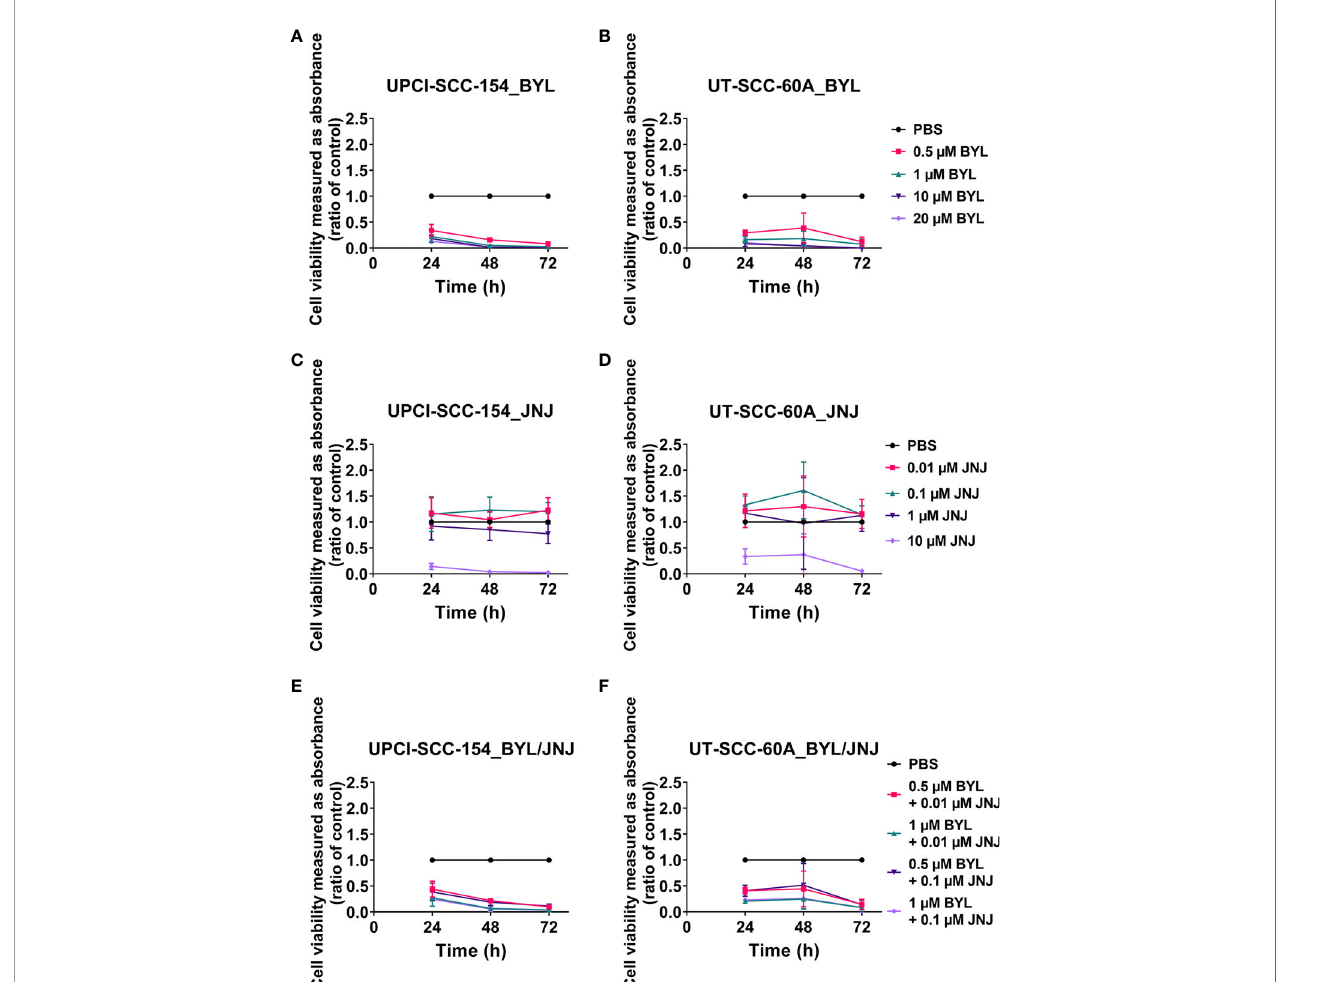
FIGURE 2 | WST-1 viability assays evaluating cellular metabolic capacity by absorbance on HPV + UPCI-SCC-154 and HPV - UT-SCC-60A cell lines upon treatment with PI3K inhibitor BYL719, and FGFR inhibitor JNJ-42756493. WST-1 viability assay measuring absorbance following treatment for 24, 48 and 72 h of HPV + UPCI- SCC-154 and HPV - UT-SCC-60A with PI3K and FGFR inhibitors, BYL719 (A, B) and JNJ-42756493 (C, D) as well as combinational treatment with BYL719 and JNJ-42756493 (E, F) . The graphs represent three experimental runs per cell line, and the data are presented with the mean ± standard deviation. BYL denotes BYL719 and JNJ denotes